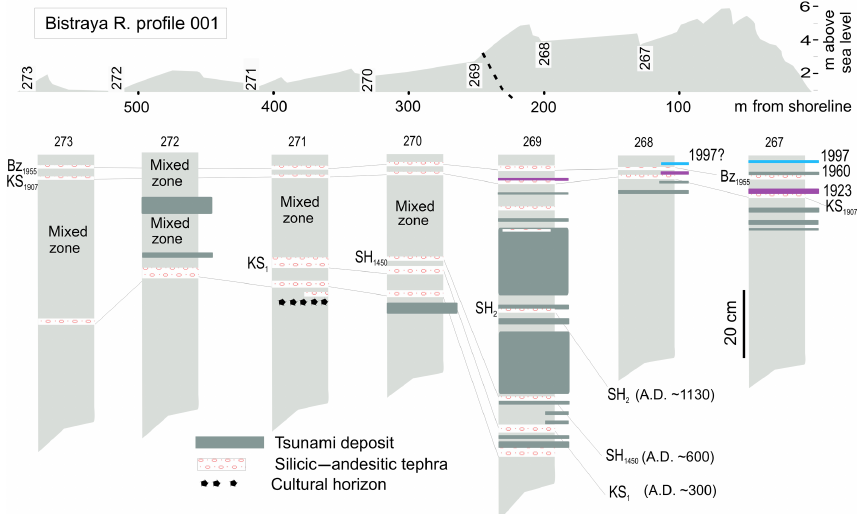
Figure 7. Northernmost profile, southern Kamchatsky Bay (Fig. 1 location; more extensive key in Fig. 4; tephra and tsunami deposits that are shown as narrower bands, e.g., 1997 in excavation 268, indicate thin, patchy deposits). This profile shows evidence of subsidence through time – the landward part of the profile is lower. This lower profile has been subjected to river erosion – the “mixed zone” is mostly fluvial sediment containing clasts of older material. Excavations with this mixed zone (273 to 270) all contain a tephra older than KS 1 , indicating that older strata are preserved below the reworked material. In this profile, there is an ash layer from the 1955 eruption of Bezymianny, a year before its major eruption. With this tephra present, we can assign the tsunami deposit above (in excavation 267) to Chile 1960 rather than to Kamchatka 1952.